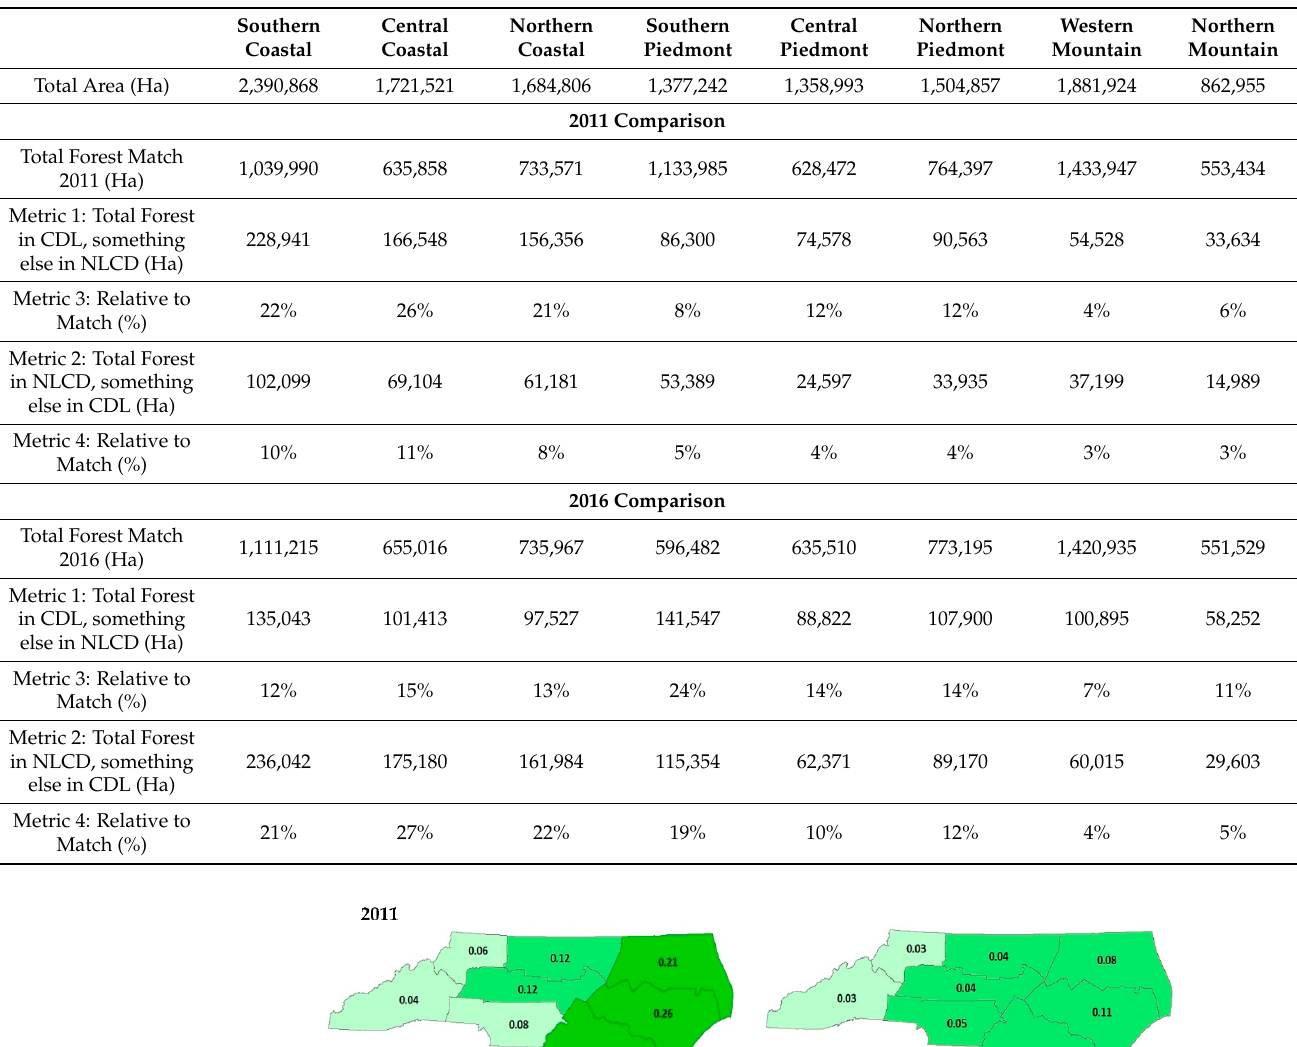
Table 4. Agricultural Statistics Districts, the total area for each (ha), total forestland that match between CDL and NLCD in 2011, and the percent relative to match.